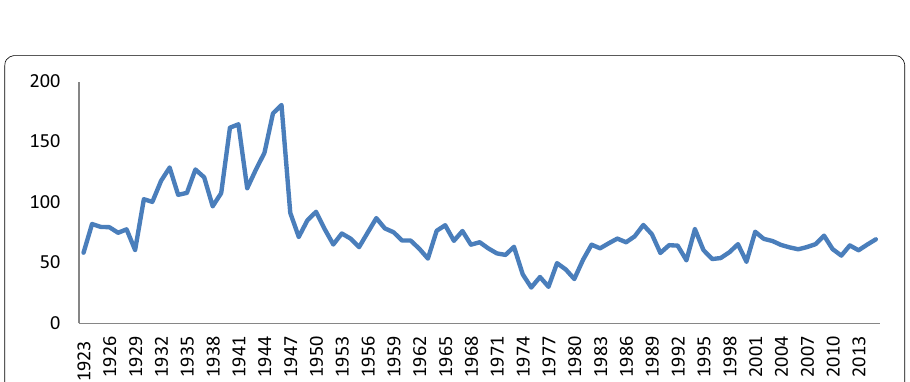
Fig. 4 Ratio of export to import in the Turkish economy (1923–2013). Source : TurkStat (foreign trade by